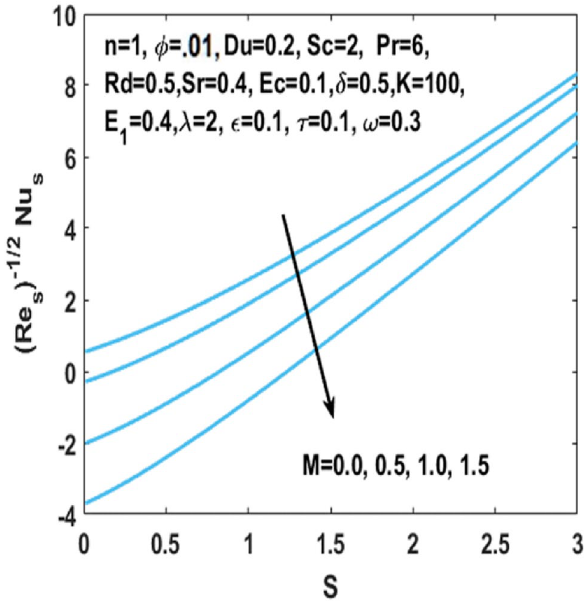
Figure 14. Impact of M on Nusselt number w.r.t S .